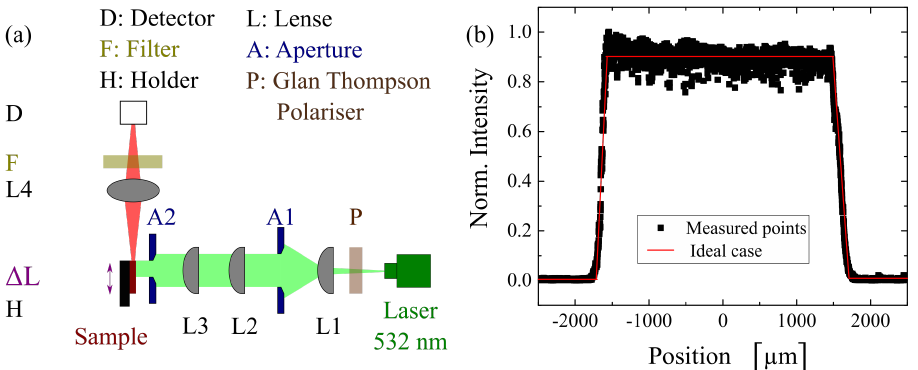
Figure 7. ( a ) The setup of the optical gain measurement and the measurement of lasing properties, and ( b ) the intensity profile of the pump light were